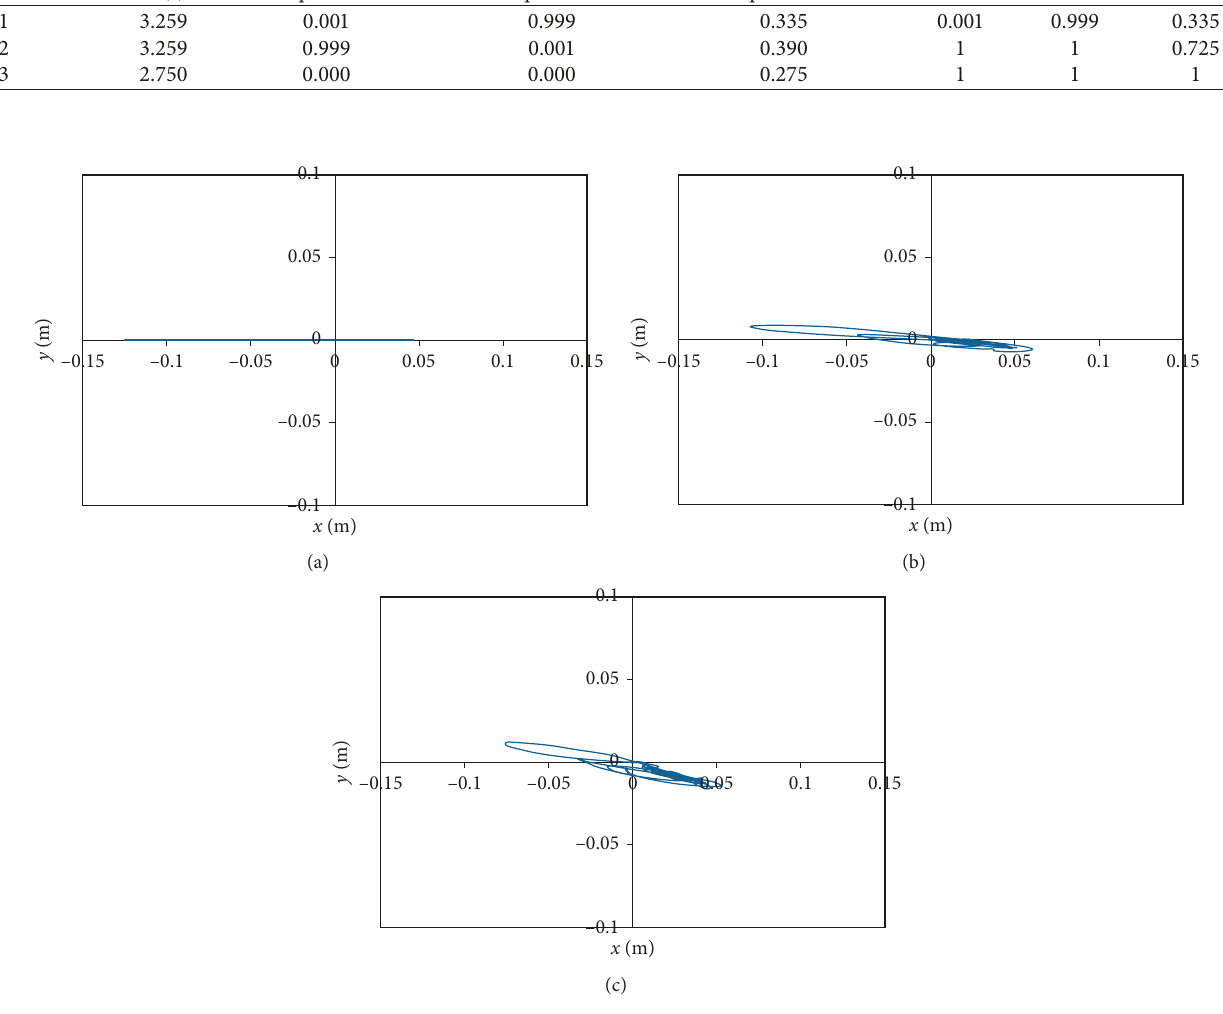
Figure 17: Five columns frame: displacements in the plane xy due to an acceleration input along x for (a) C10, (b) C23 with μ with μ b